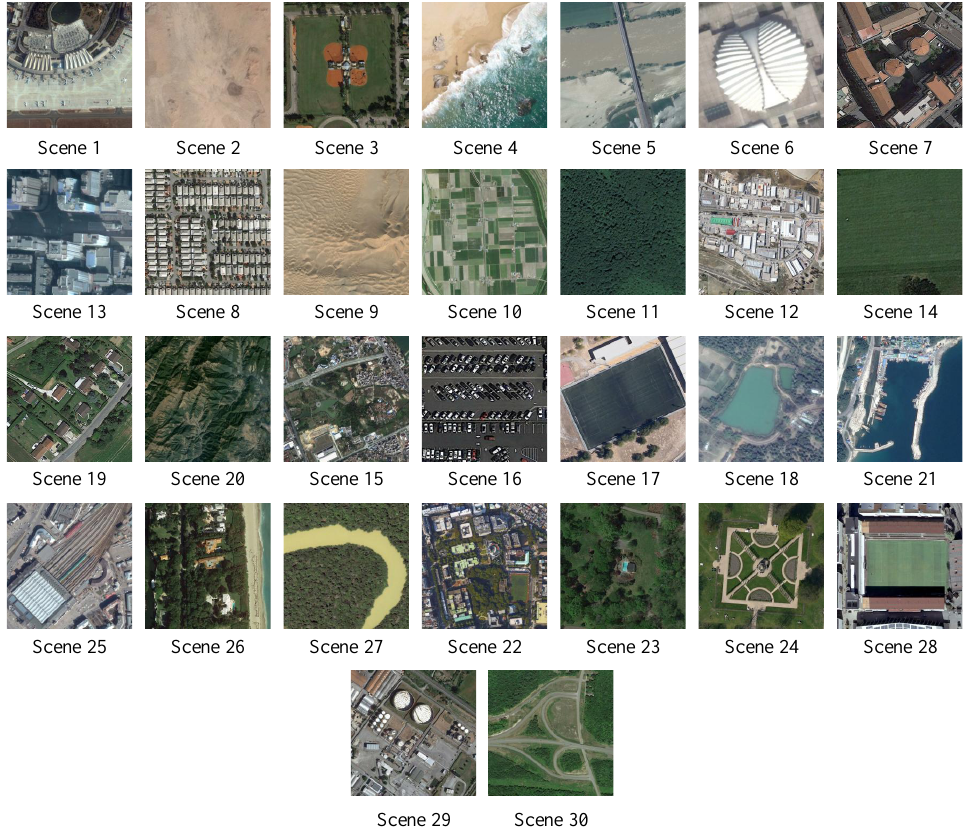
Figure 6. Examples of different scenes in AID dataset. The names of scenes can be found in Table 2.